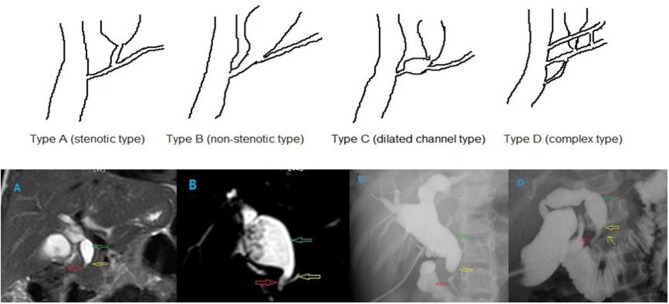
Different types of PBM. (A) stenotic type, (B) non-stenotic type, (C) dilated channel type, and (D) complex type. The common channel (the red hollow arrow), the pancreatic duct (the yellow hollow arrow), and the dilated bile duct (the green hollow arrow). In the type D PBM, there was a accessory pancreatic duct (the yellow arrow).